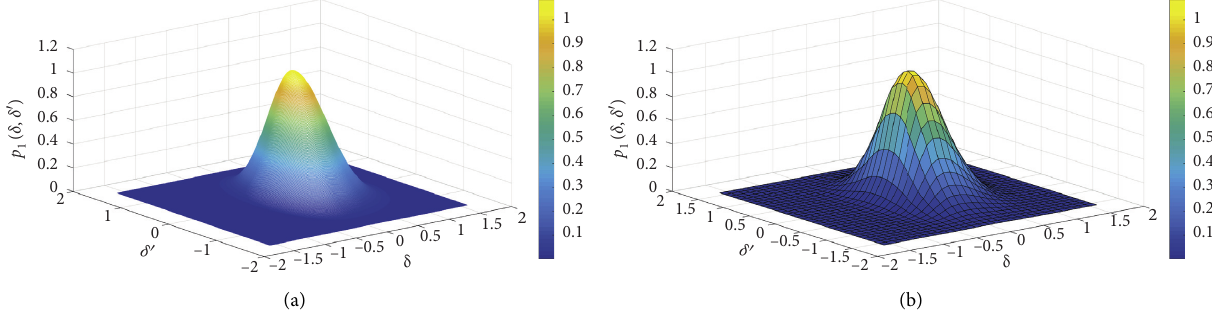
be compensated in the system so that the displacement PDF p ( δ ) is closer to Gaussian distribution. It is interesting to 1 find that as α tends to 0 (the system damping tends to 0), p ( δ ) approaches a uniform distribution. 1 placement PDFs of ATNPS can be plotted for various values of the strains d and d of the packaging cushion materials in 1 2 Figure 7. Letting d equal to d , with the d and d increase 1 2 1 2 ( δ ) approaches simultaneously, the displacement PDF p 1 Gaussian distributions. Otherwise, the displacement PDF p ( δ ) presents distinct non-Gaussian character. Displace- 1 ment responses are limited to less than d and d because the 1 2 nonlinear restoring force f ( δ ) of the system follows asym- metric tangent type with the boundary strain of d and d . 1 2